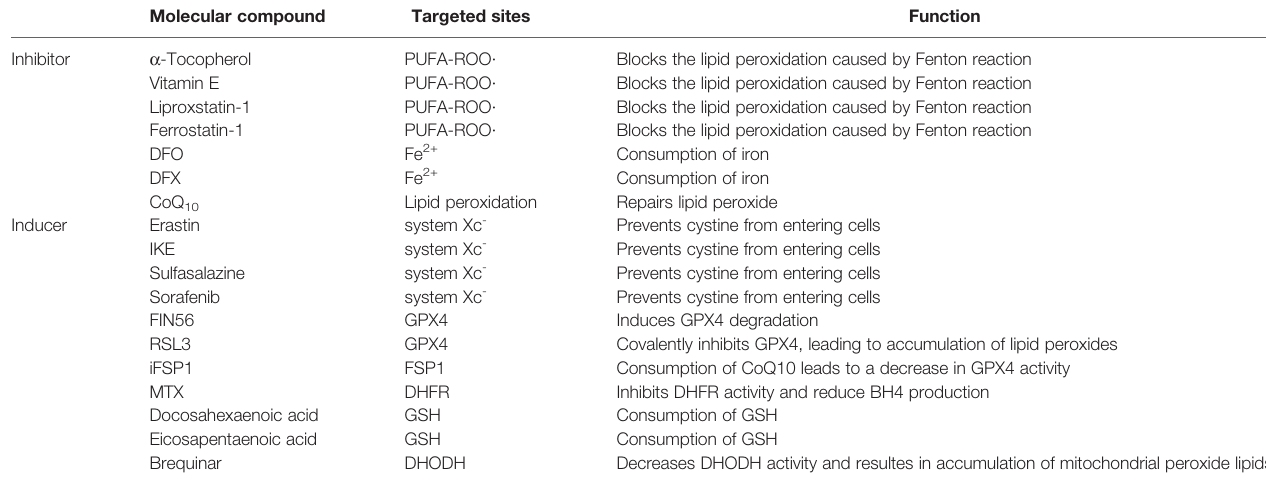
TABLE 2 | Molecular compounds that regulate ferroptosis. Molecular